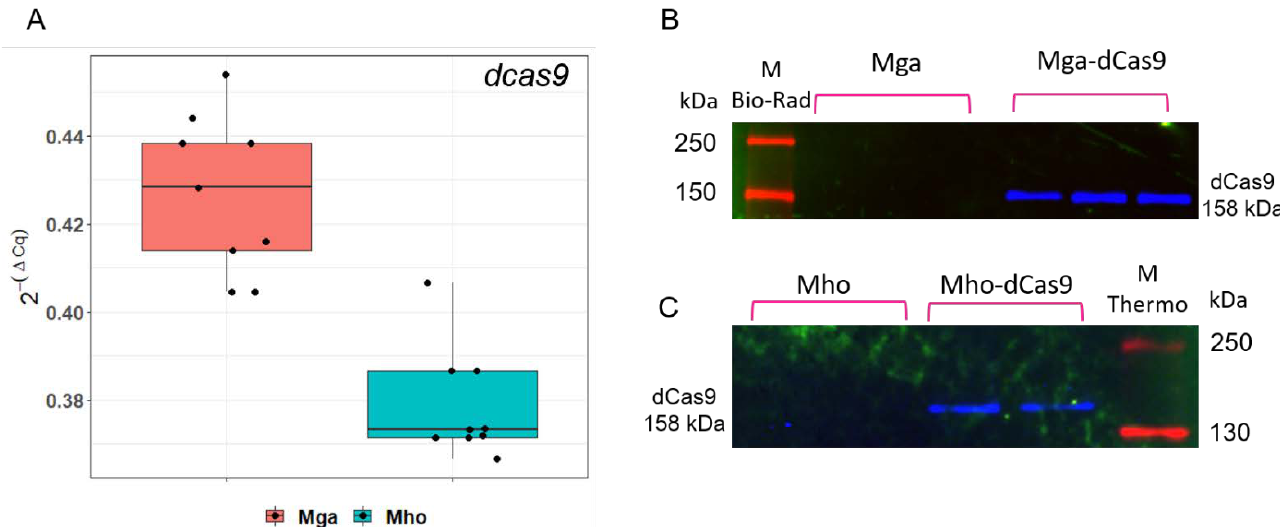
Figure 2. Validation of dcas9 expression at mRNA and protein levels ( A ) Transcription analysis of dcas9 by qRT-PCR in transformants of M. gallisepticum (Mga) and M. hominis (Mho). Quantitative dcas9 expression was normalized to the expression level of tuf for both species. Boxplot was plotted from three repeated experiments (three independent transformants and three technical repeats for each). ( B,C ) dCas9 protein level by Western blot for wild-type M. gallisepticum, M. hominis and pRLM5L2- dcas9 transformants.